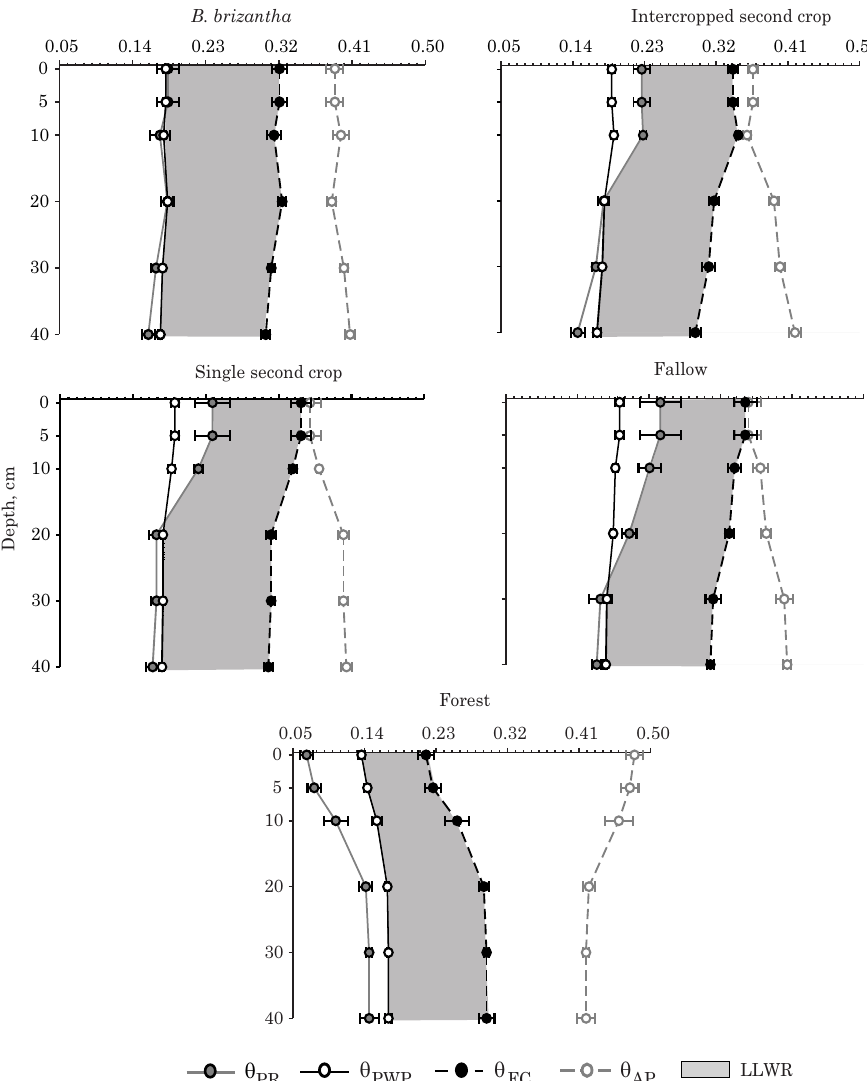
Figure 1. Variation of soil water content ( θθθθθ ) at different depths for the critical limits of soil resistance to penetration ( θθθθθ PR ), permanent wilting point ( θθθθθ PWP ), field capacity ( θθθθθ FC ) and aeration porosity ( θθθθθ AP ) of the dystrophic Red Latosol under different systems of soil use and management during the between-crop season of soybean cultivation. LLWR: Least Limiting Water